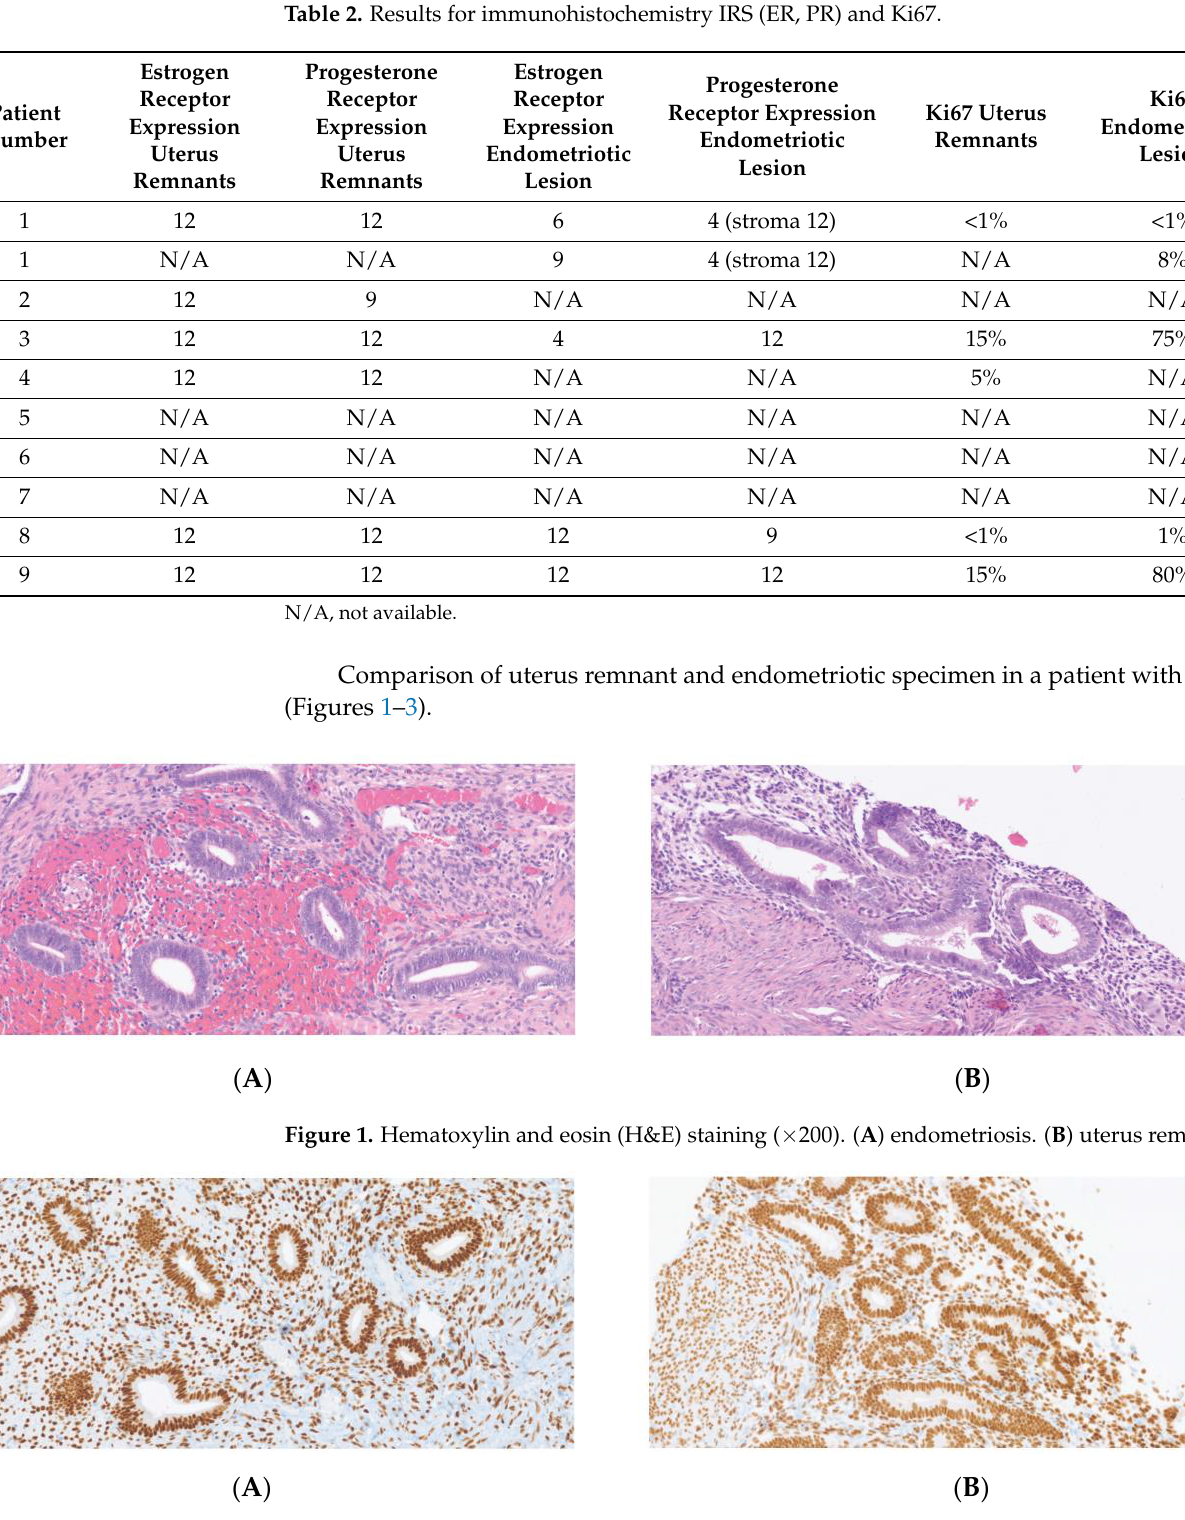
Figure 2. Estrogen receptor (ER) with strong nuclear expression (×200). ( A ) endometriosis. ( B ) uterus remnant.